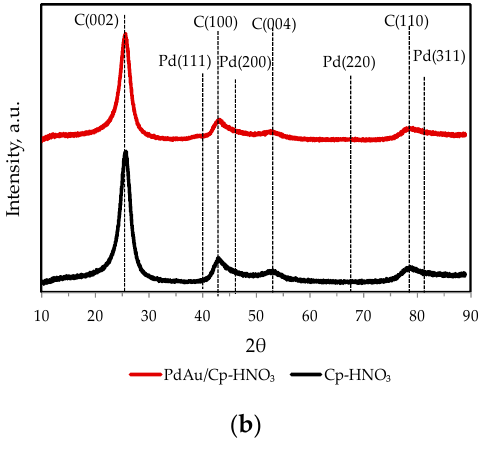
Table 4. Analytical content of Pd and Au in Sibunit-supported catalysts with different support treatment.